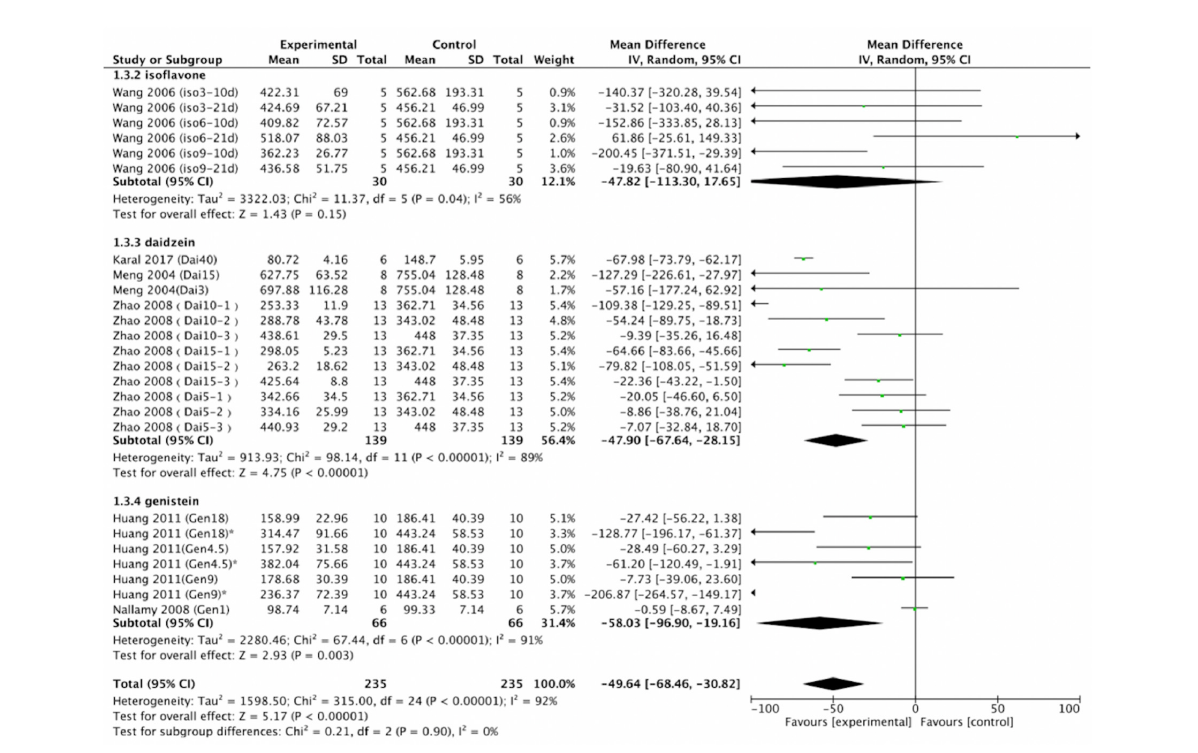
FIGURE8 Forest plot of the effects of soy on serum and plasma uric acid concentration. Subgroup analyses evaluated the effects of daidzein, soy protein, genistein, and unspecified soy isoflavones (SD, standard deviation; CI, confidence interval; IV, inverse variance; µ mol/L).